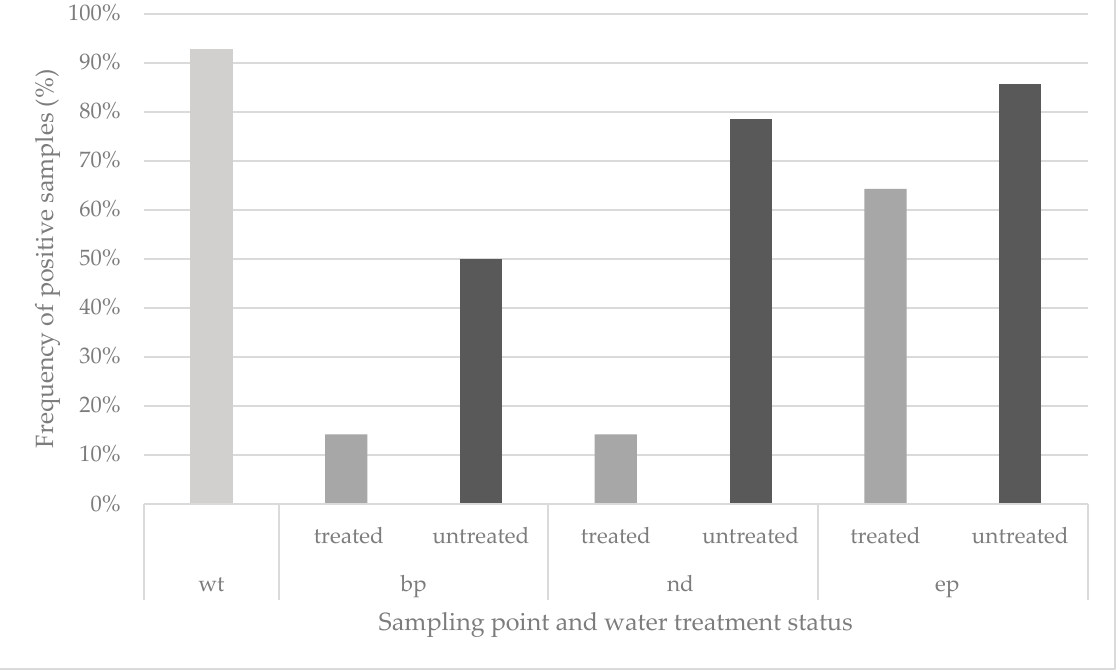
Figure 3. Detection of coliform bacteria in incoming (well) water (wt) and in samples from treated and untreated pipes with bp = beginning of the pipes, nd = nipple drinker and ep = end of the pipes. wt: = well water.